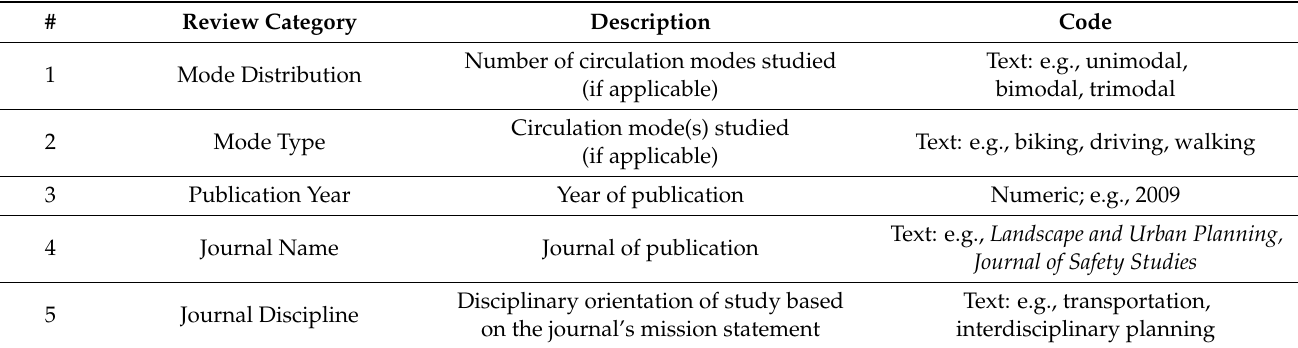
Table 1. Descriptions and codes of review